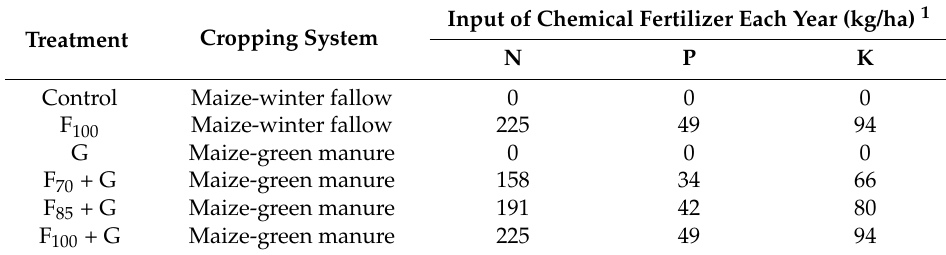
Table 1. Cropping system and chemical fertilizer input for each treatment.